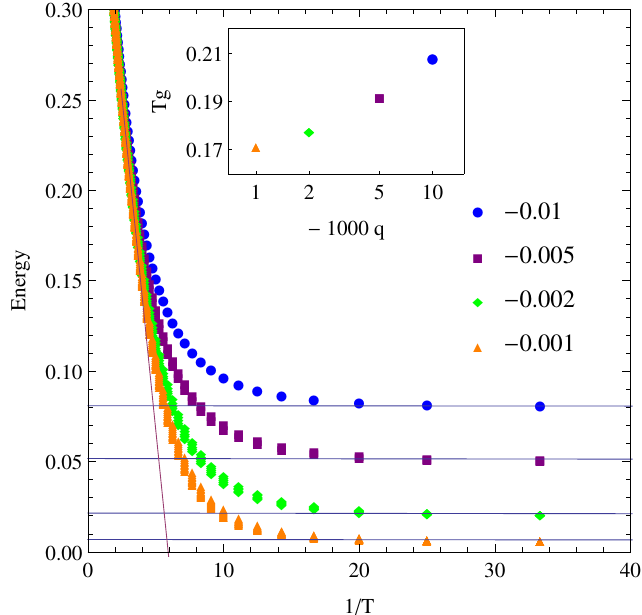
Figure 3. Energy evolution on cooling of an open cluster ( h = 0.1 and h (cid:48) = 1) according to the reciprocal of temperature for different cooling rates from q = − 0.01 T units/MS to q = − 0.001 T units/MS. The liquid and glass lines are included to obtain the T g at the intersection of both lines. The inset shows a glass transition temperature dependence with cooling